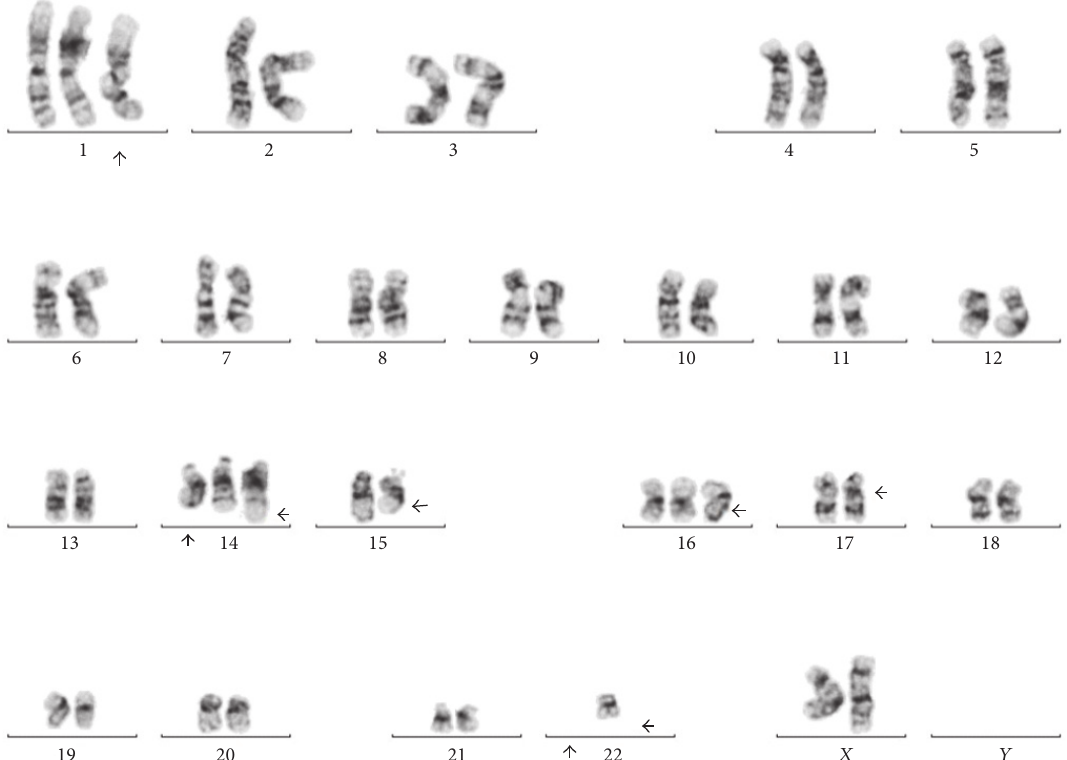
Figure 8: Bone marrow specimen showing 48,XX,+1,+14,t(14;22)(q32;q11.2),add(15)(q22),+16,add(16)(q12-13),add(17)(p11.2), −